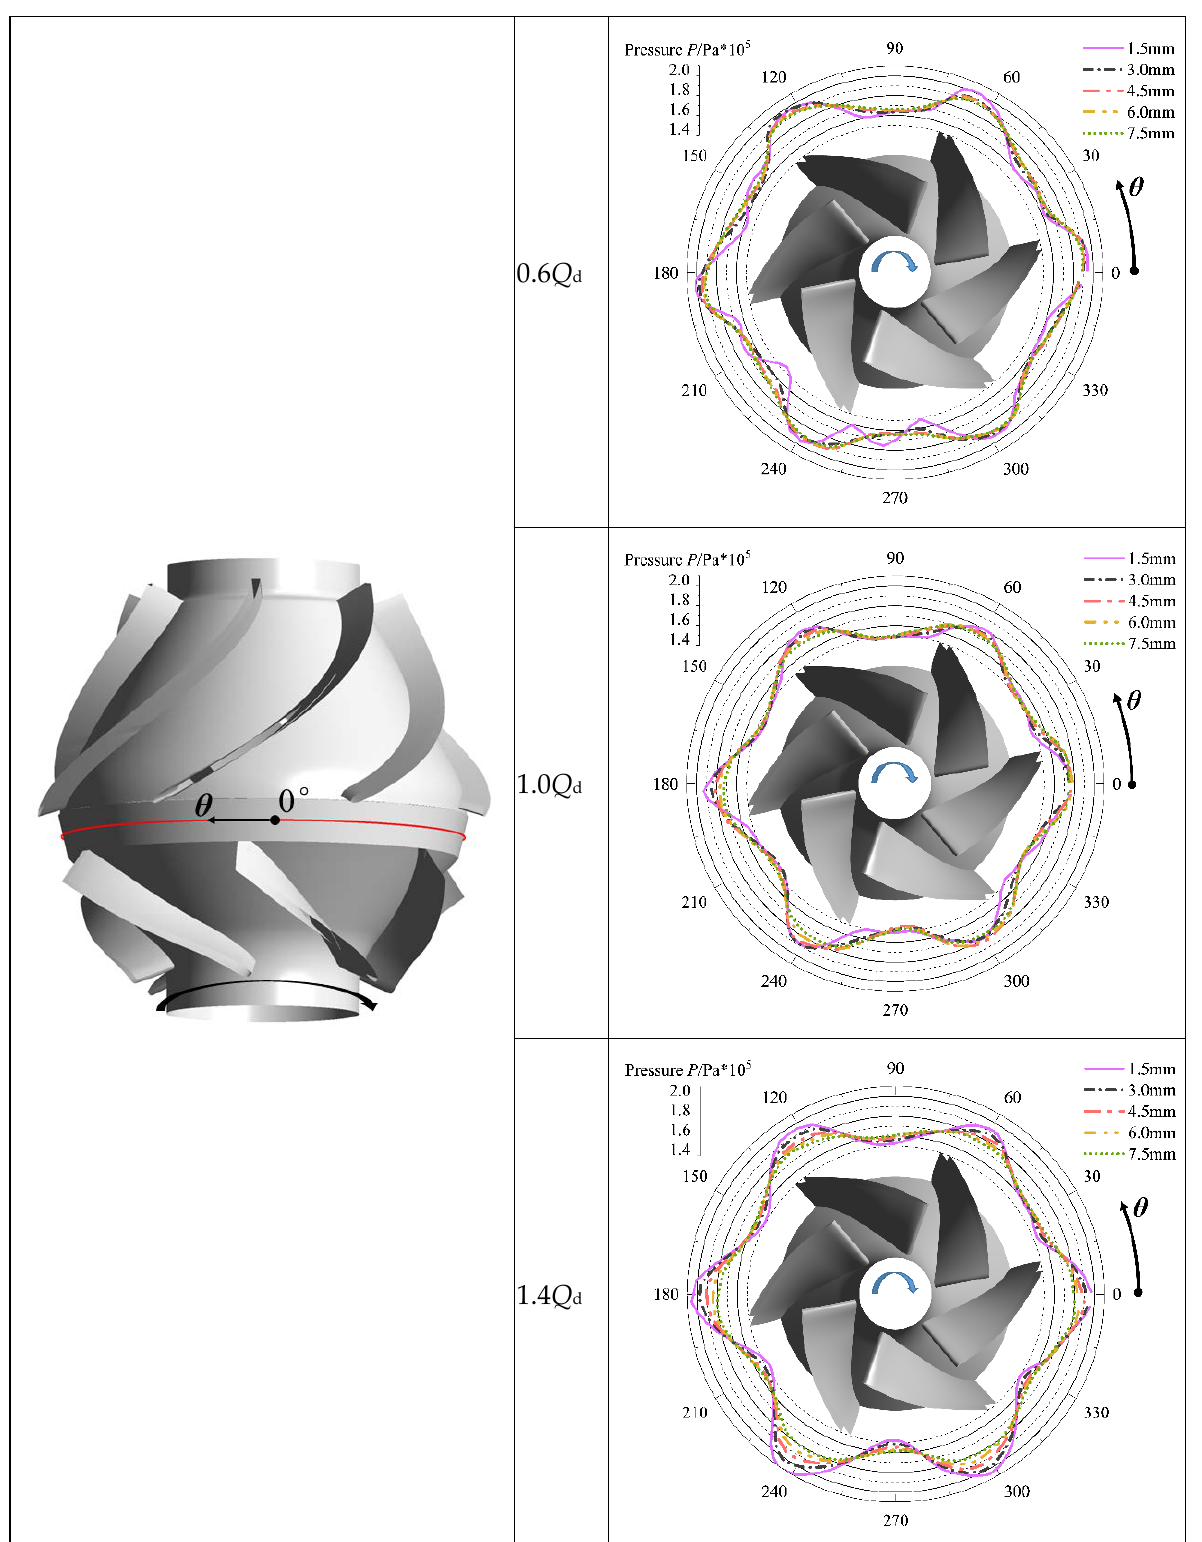
Figure 11. Pressure distribution on the mid-span midline within the chamber.